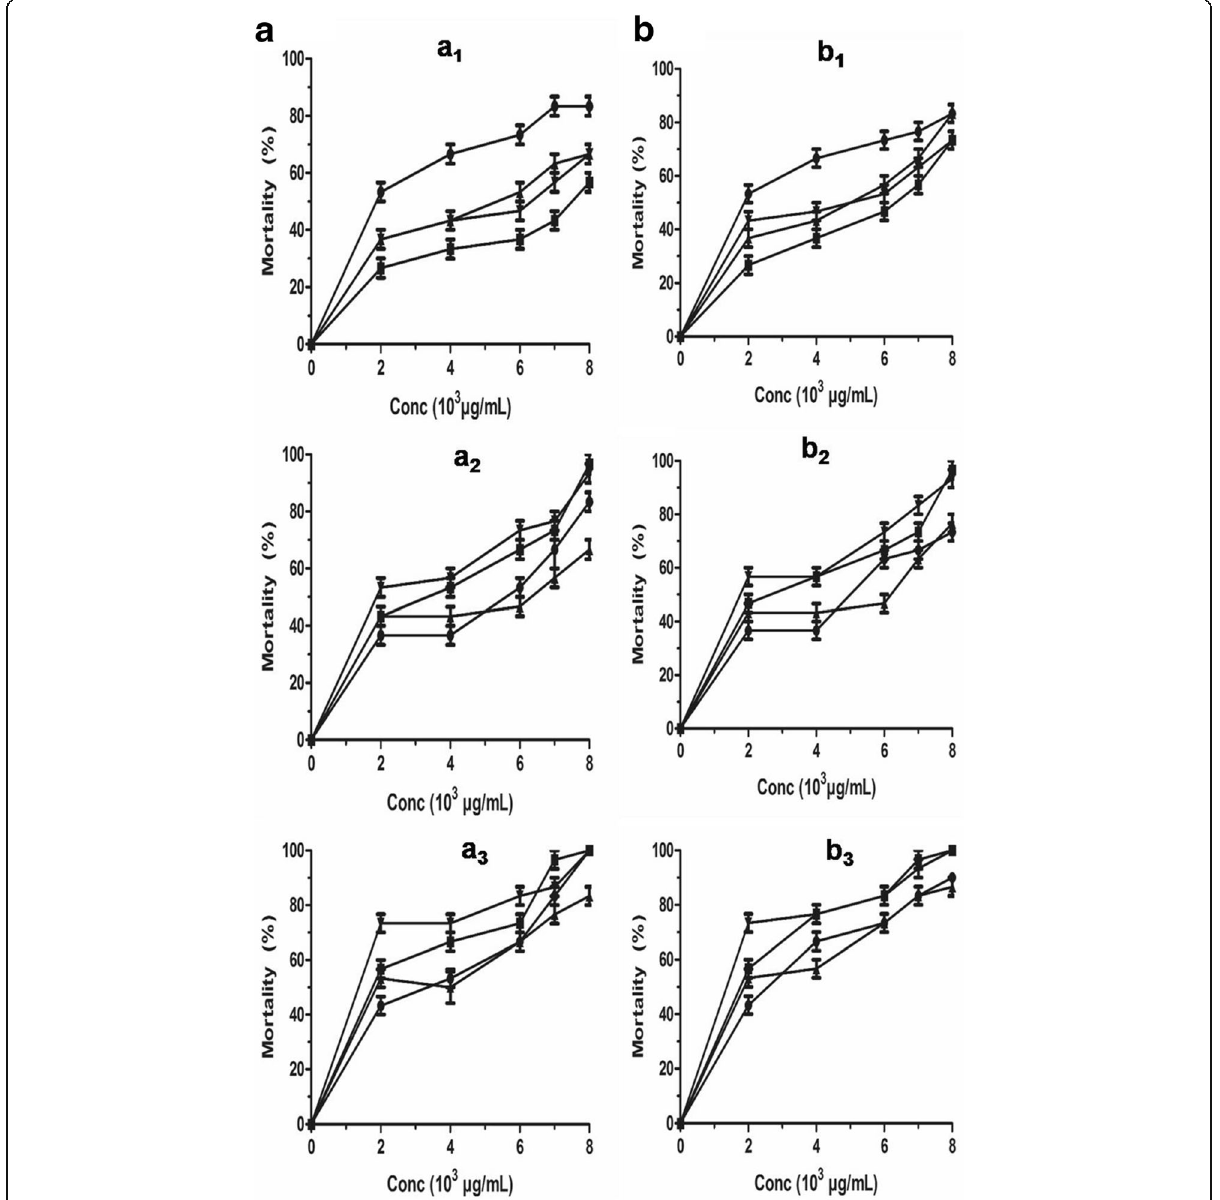
Fig. 3 Effects of plant extracts against C. elegans wild type and drug resistant strains with ( a ) crude alcoholic and ( b ) MeOH-CH 2 Cl 2 extracts from L. lanceolata 72 h post-exposure ( ● ) VC722, ( ■ ) CB3474, ( ▲ ) CB211 and ( ▼ )WT: (a 1 , b 1 ) leaves; (a 2 , b 2 ) trunk bark and (a 3 , b 3 ) root bark. Data are mean ± SEM from three independent duplicate